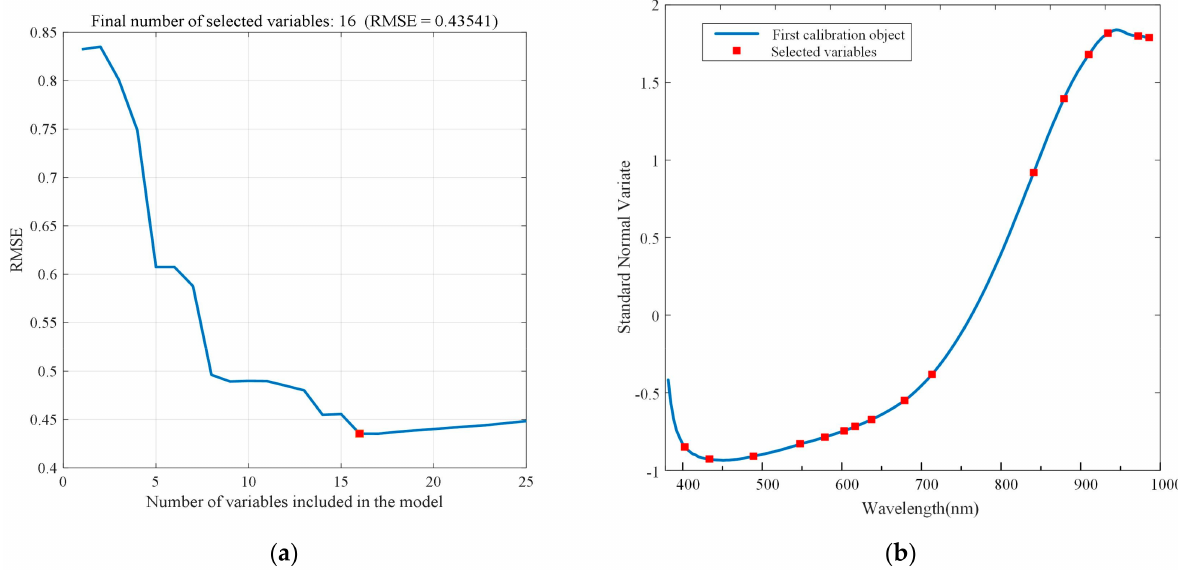
Figure 9. Selection of characteristic wavelengths using SPA after SNV preprocessing: ( a ) number of effective variables and ( b ) visualized characteristic wavelengths in the raw